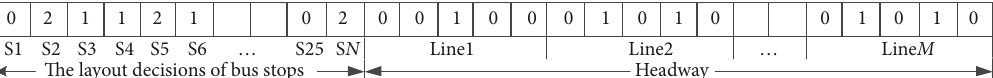
Figure 3: The expression of